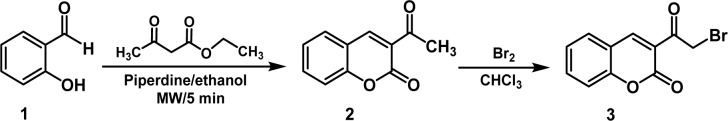
Synthesis of 3-(bromoacetyl)coumarin (3)